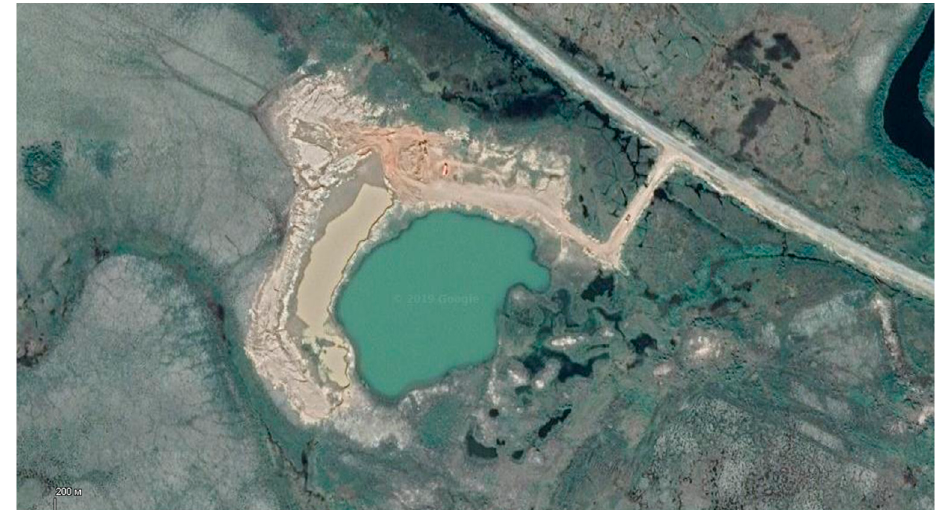
Figure 3. A 2018 photo of a dredged lake which is now